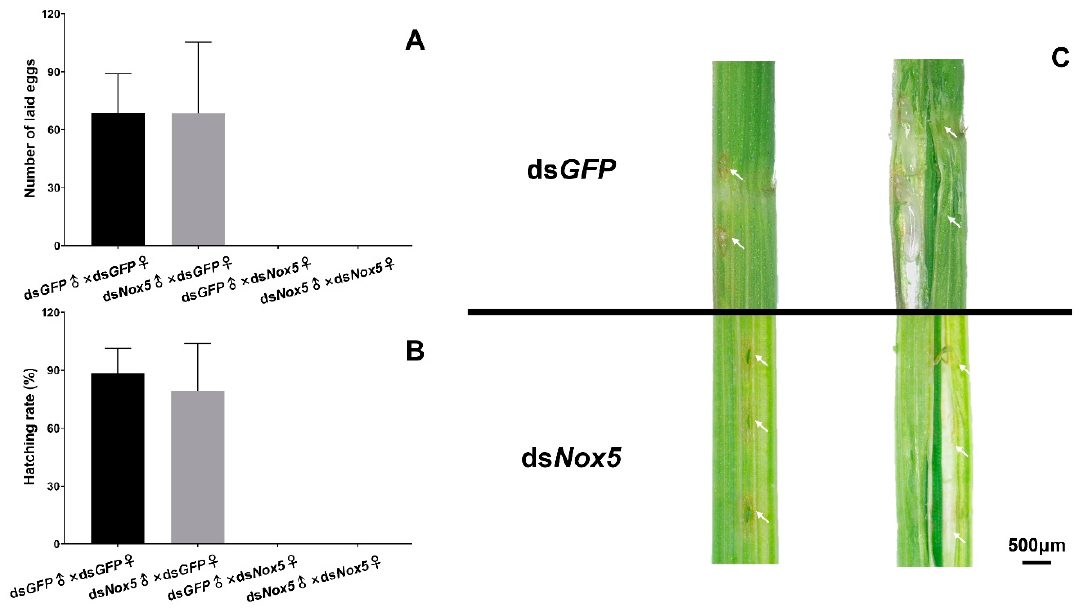
Figure 5. RNAi of Nox5 effects on egg-laying and hatching. ( A ) Calculation of egg-laying rates. The 5th-instar nymphs were injected with ds Nox5 and the newly emerged female adults were mated with male adults. The number of eggs laid in rice leaf sheaths from each mating pair was calculated. The x -axis indicates each mating pair, namely, ds GFP -treated females and males; ds GFP -treated females and ds Nox5 -treated males; ds Nox5 -treated females and ds GFP -treated males; ds Nox5 -treated females and males. The y -axis shows the number of eggs laid from each mating pair. Three biological replicates (mean ± SD) were carried out (n=15–20 ♀×♂ ). ( B ) Determination of hatching rates. Hatching rates were calculated from the eggs laid in rice leaf sheaths from each mating pair as described above. Three biological replicates (mean ± SD) were carried out (n=15–20 ♀×♂ ). ( C ) Observation of the eggs laid in the rice leaf sheath. The eggs were dissected from the rice leaf sheath at the 3rd day after oviposition of ds Nox5 - and ds GFP -injected females that mated with male adults. The arrows indicate the egg-laying sites in the rice leaf sheath.